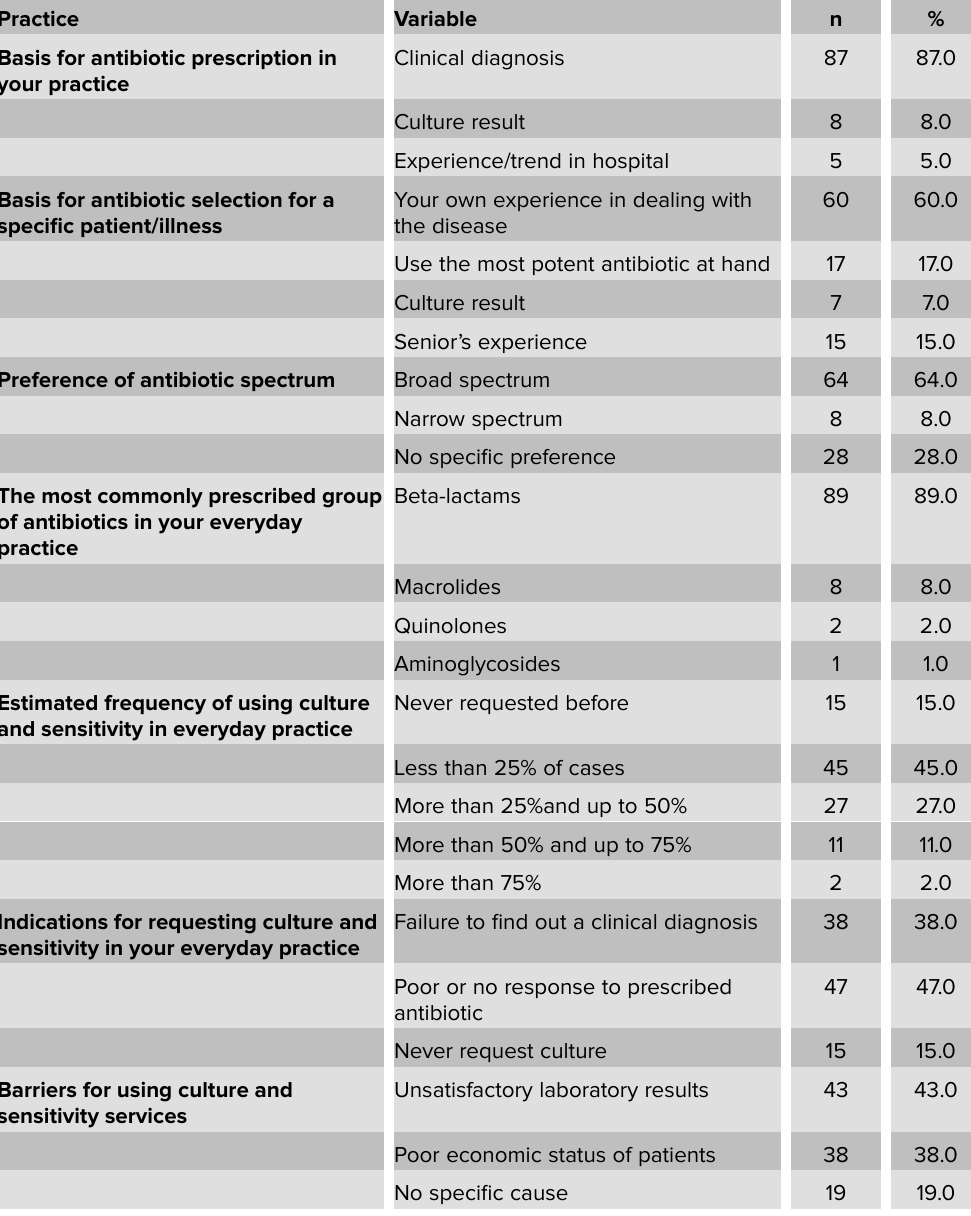
Table 2: The common practices of treating doctors towards antibiotic prescription in River Nile State, Sudan 2014